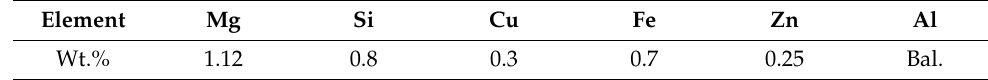
Figure 1. SEM images of ( a ) nano ‐ AlN and ( c ) AA6061 powders. ( b , d ) The particle size histograms of nano ‐ AlN and AA6061 powders, respectively. Table 1. Chemical compositions of AA6061